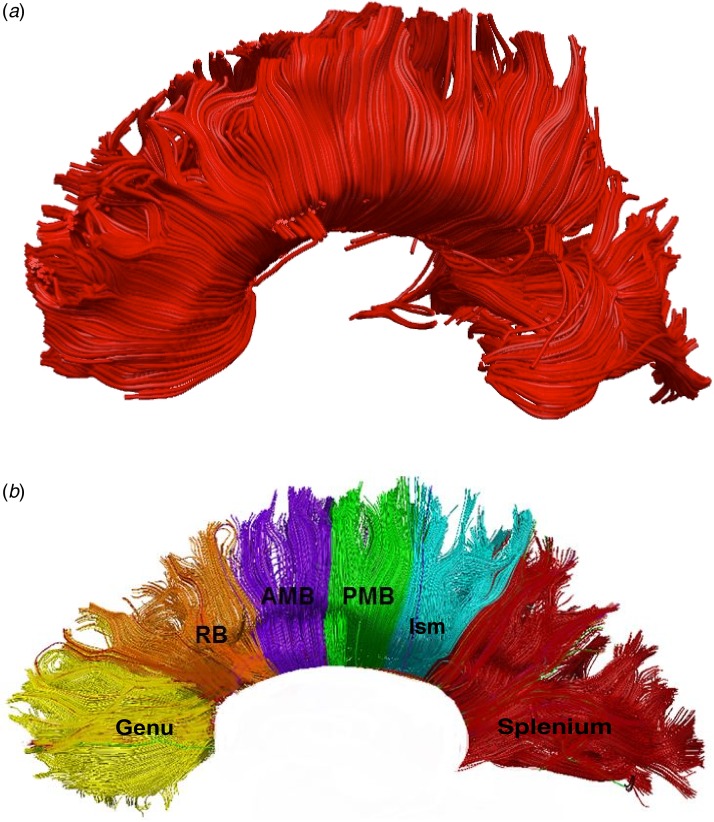
Corpus callosum tract: whole (a) and segmented
(b). Regions of interest as defined according to Witelson (1989) subdivisions. RB, Rostral body; AMB,
anterior mid-body; PMB, posterior mid-body; Ism, isthmus. For a colour figure, see
the online version.